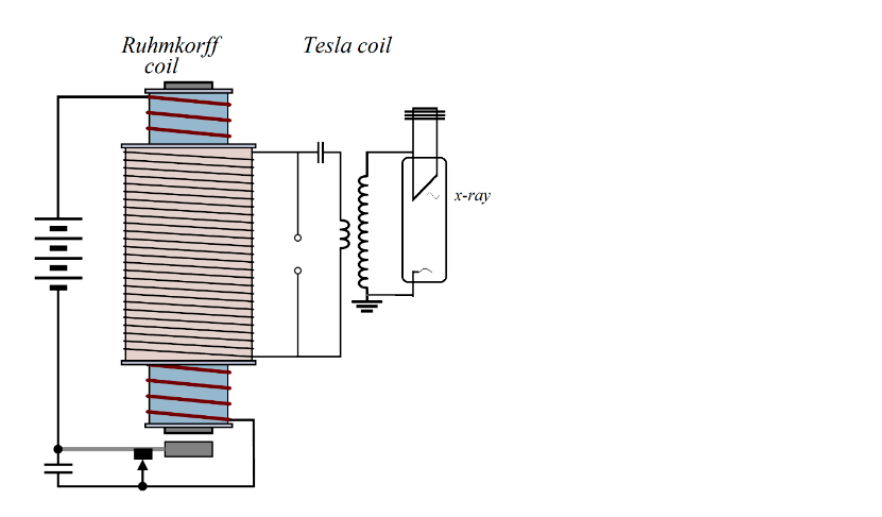
Figure 6. Schematic diagram of the high voltage source J. C. Bose probably used.